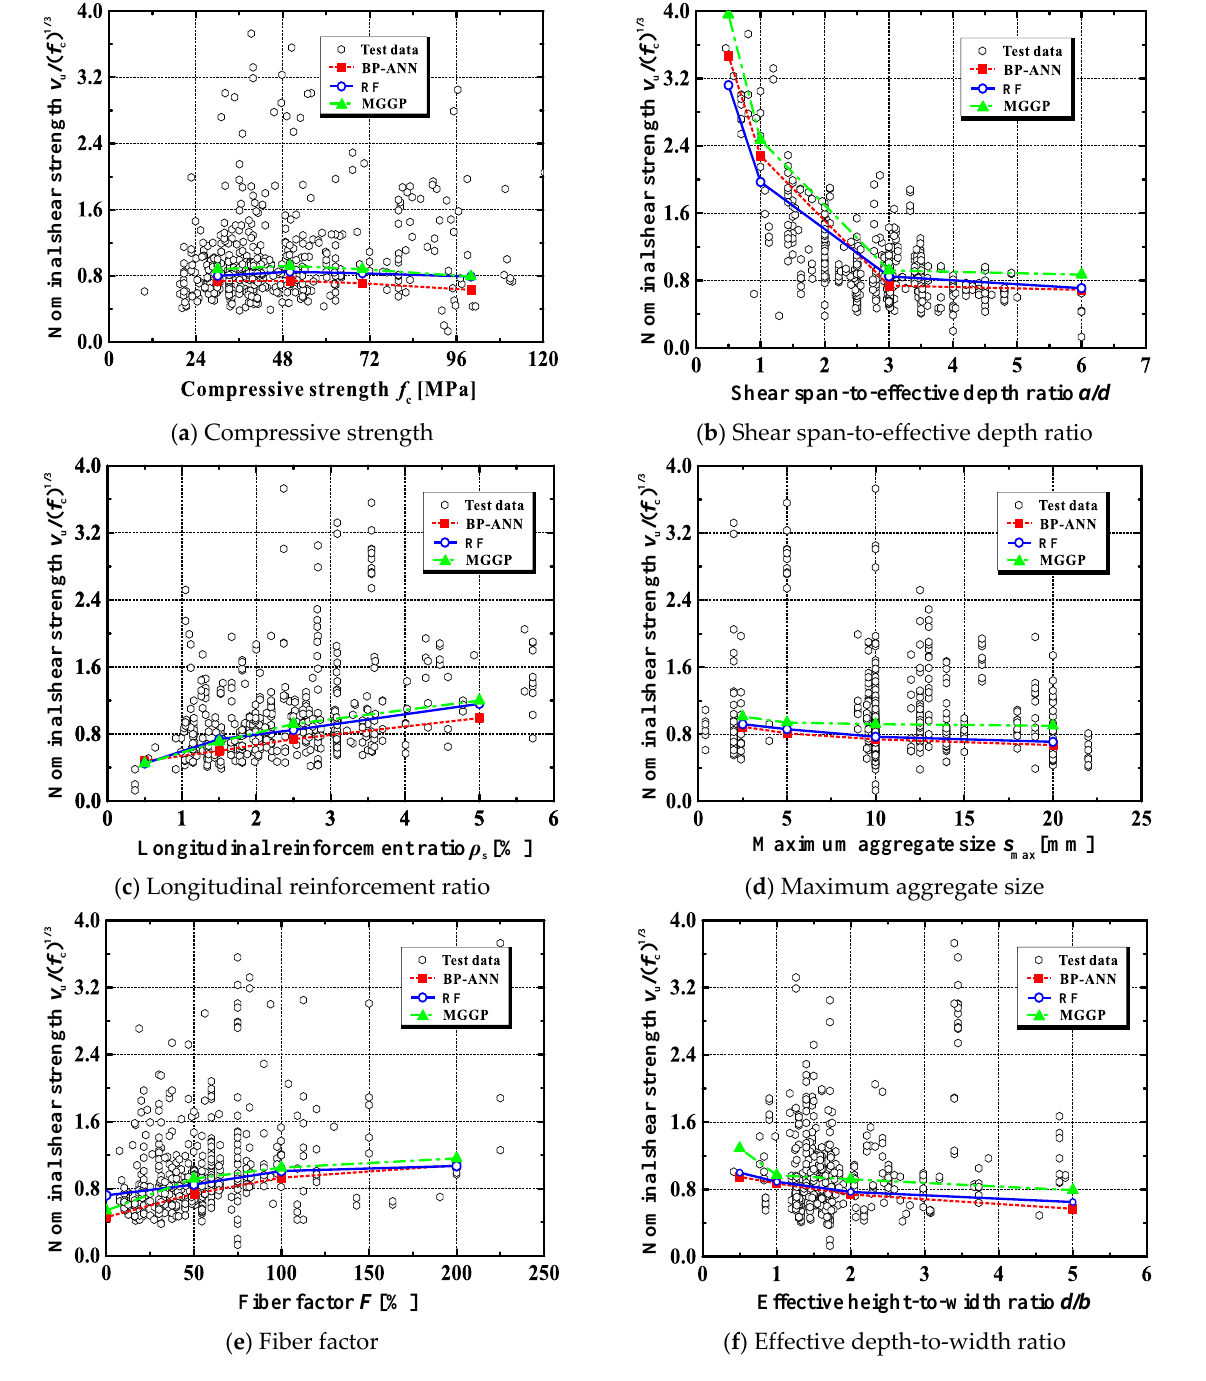
Figure 8. Main parameters affecting the shear strength of SFRC beams without stirrups.